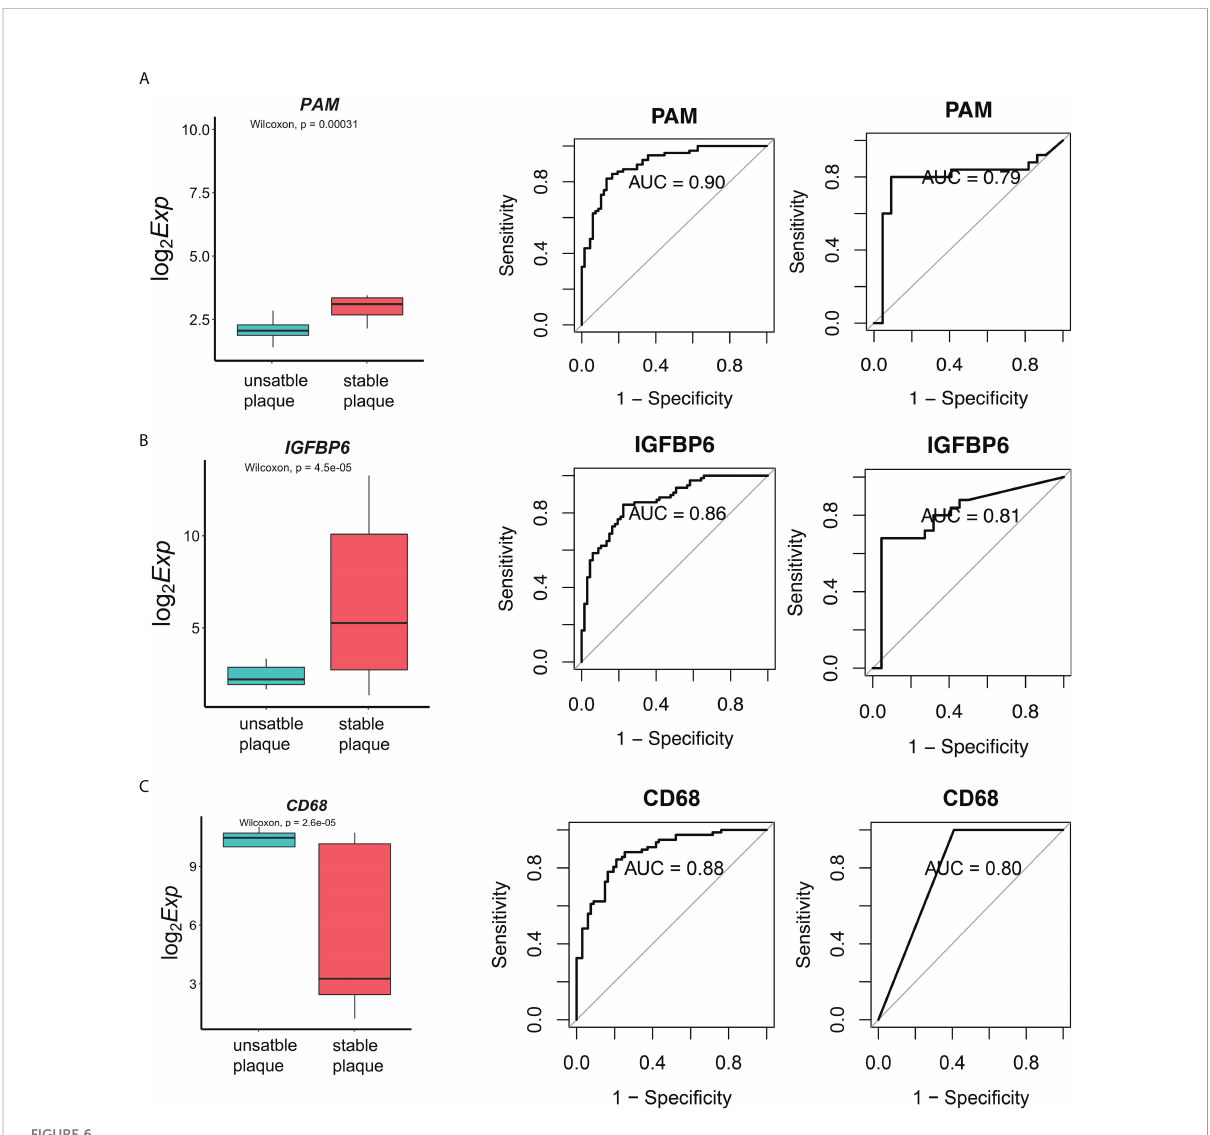
FIGURE 6 Diagnostic effectiveness of the biomarkers. (A) The E-MTAB-2055 dataset was used to validate the differential expression for gene PAM. Diagnostic effectiveness of the PAM by ROC analysis in the training set and validation dataset. (B, C) Expression levels and diagnostic effectiveness of IGFBP6 and CD68 in the training set and validation